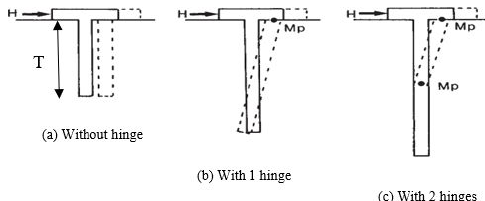
Figure 1: Pile failure modes due to lateral loads [9]